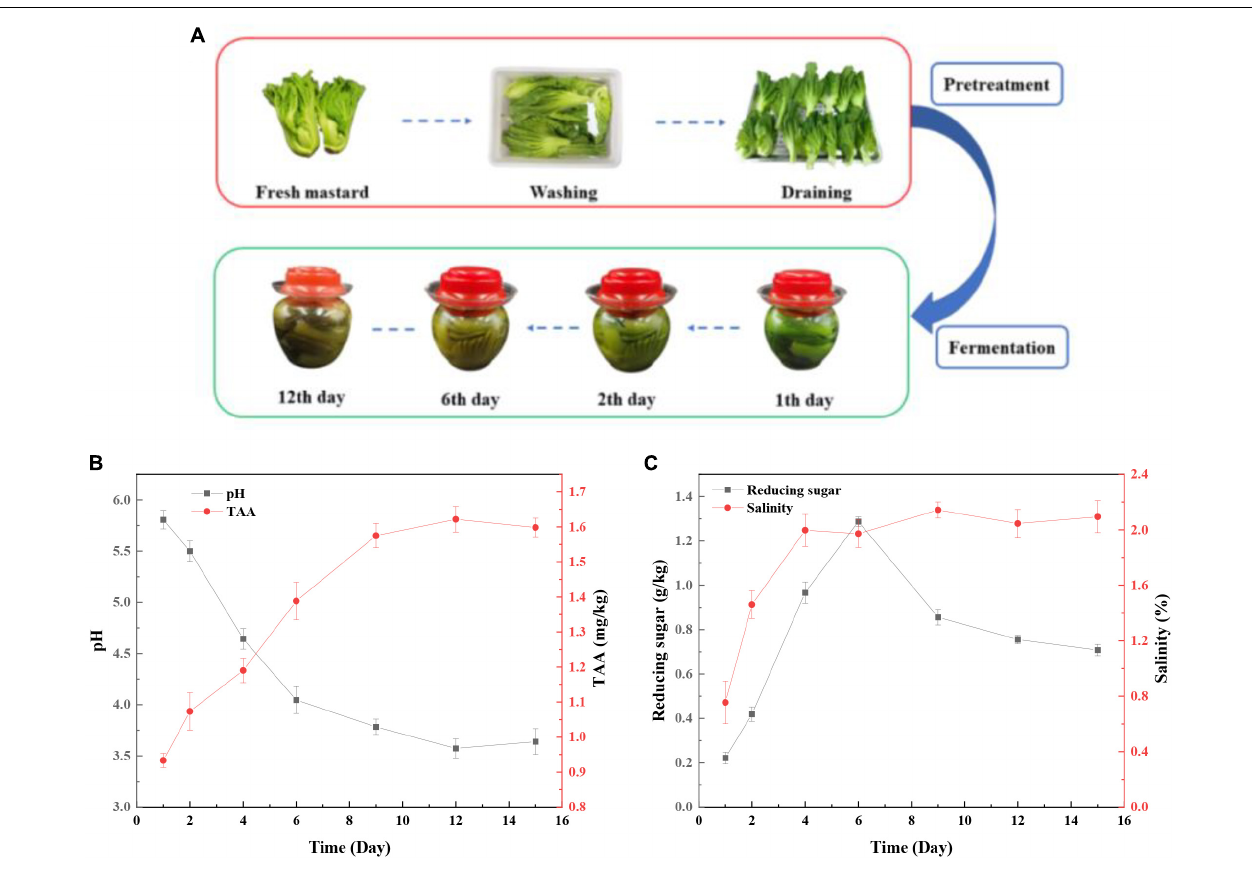
FIGURE 1 | Changes in the physicochemical properties during the mustard fermentation. (A) The process of pretreatment and fermentation of fresh mustard. (B) pH and total titratable acidity (TTA). (C) Reducing sugar and